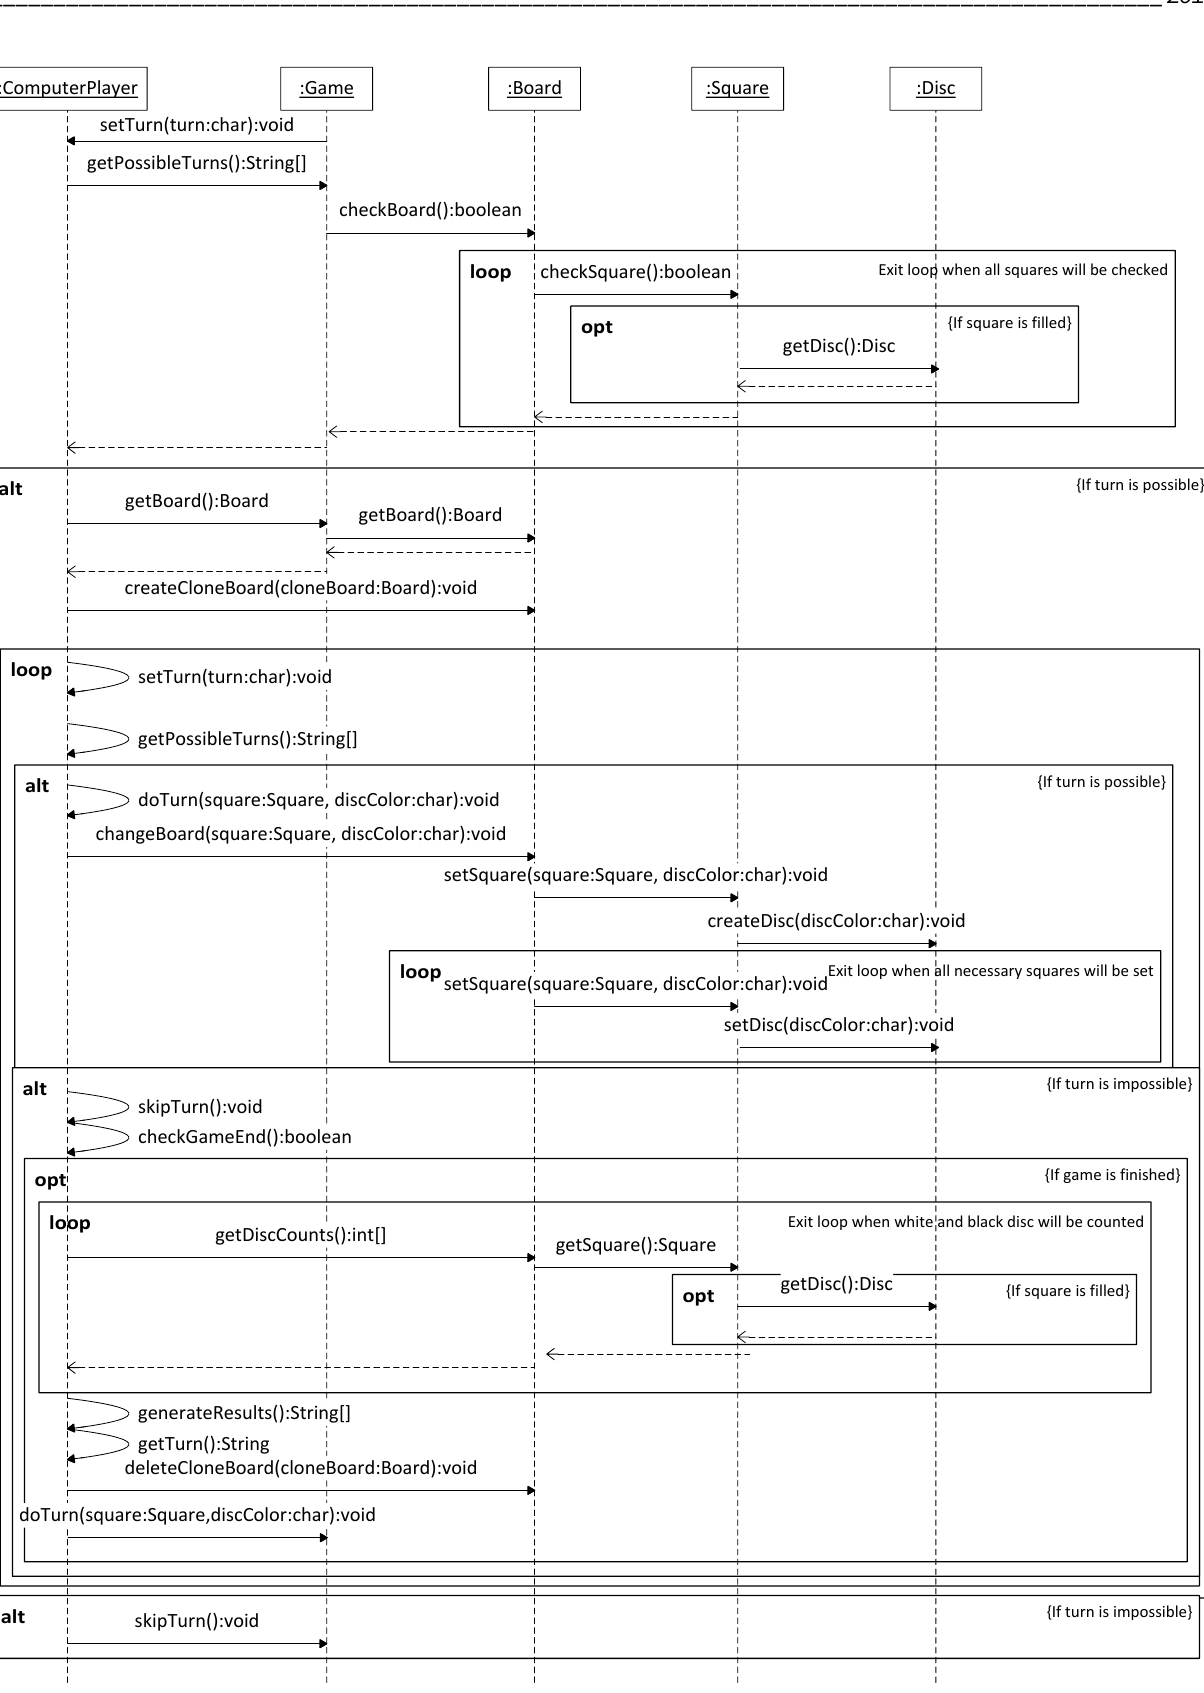
Fig. 5. The UML sequence diagram with the system goal “Do turn by a computer